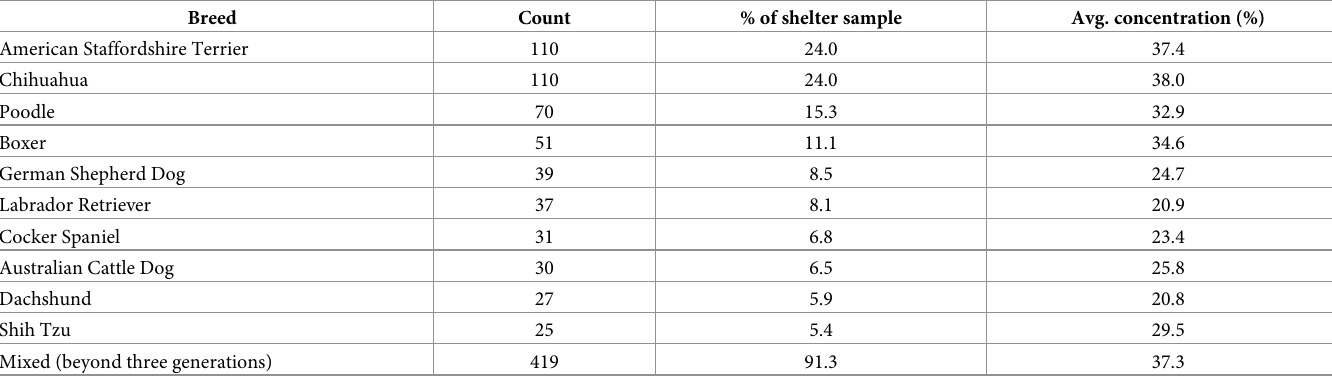
Table 3. Most commonly observed breed signatures at Arizona Animal Welfare League. Breed